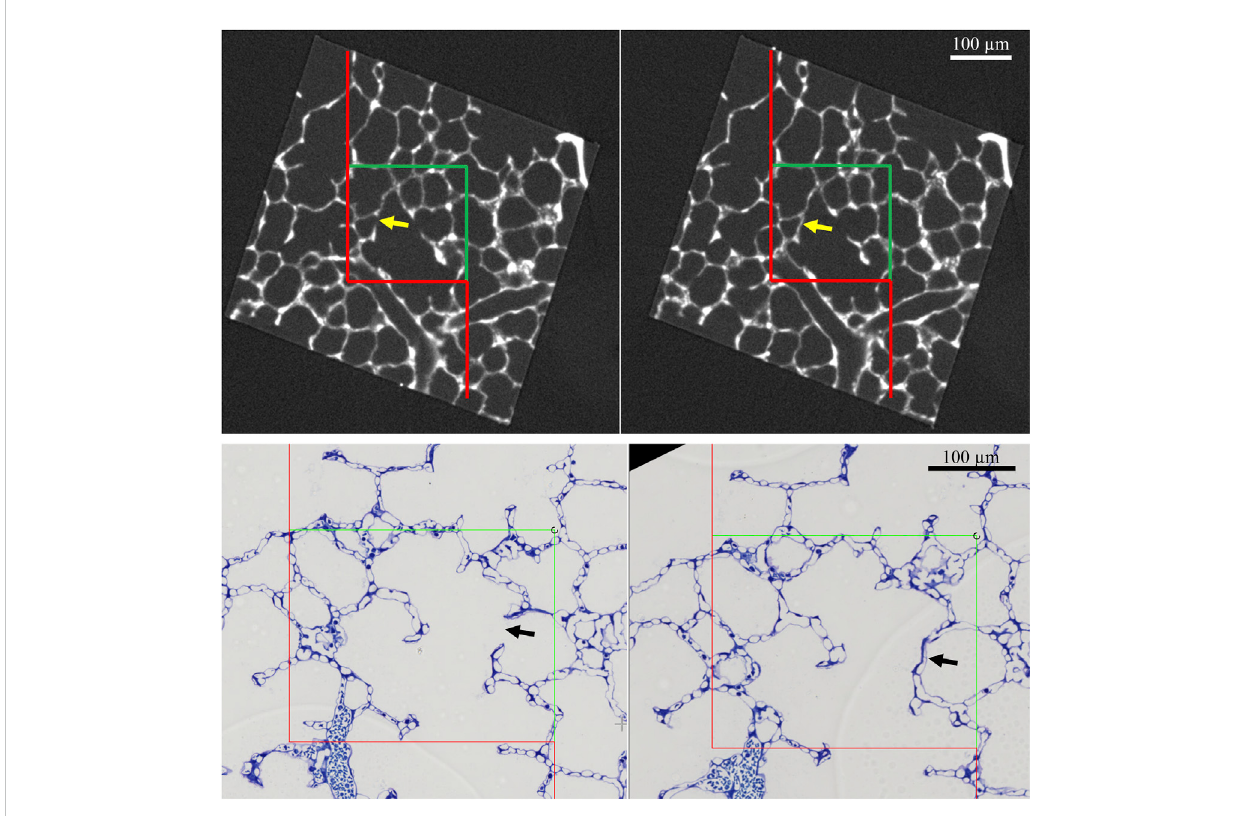
FIGURE 12 Countingopenalveoli.Top:Amouselungwas fi xed insitu byvascularperfusion via therightventricleatanairwayopeningpressureof10 cmH 2 Oon expiration after two recruitment maneuvers (3 s pause at 30 cmH 2 O). Tissue was sampled, treated with OsO 4 and embedded in epoxy resin (Ruhl et al., 2019).Atissueblockwasimagedbymicrocomputedtomography(NanotomM,WaygateTechnology,Wunsdorf, Germany)atavoxelsize1 µm.Apairof images from the stack showing the same region is given. The distance from the top of the left image to the top of the right image is 4 µm. An unbiased counting frame of the area A Frame is superimposed on the images. The counting frame area and the distance between the counting frames generates a test volume. In this test volume, the number of alveolar openings are determined as follows: alveoli open to the alveolar duct on one image but not on the other (arrow) are counted, provided that the opening to the duct is located within the counting frame and does not touch the red line (= forbidden line). Bottom: A healthy rat lung was fi xed in vivo by vascular perfusion via the vena cava caudalis at an airway opening pressure of 10 cmH 2 O after two recruitment maneuvers (3 s pause at 30 cmH 2 O) (Knudsen et al., 2018). After randomized sampling and embedding, serial sections of a thickness of 1.5 µm were cut. The 1 st and the 4 th section of a consecutive row of sections was collected and randomized pairs of fi elds of view showing corresponding regions from these 2 sections were images. An example is given here. The arrow points at a counting event which is de fi ned